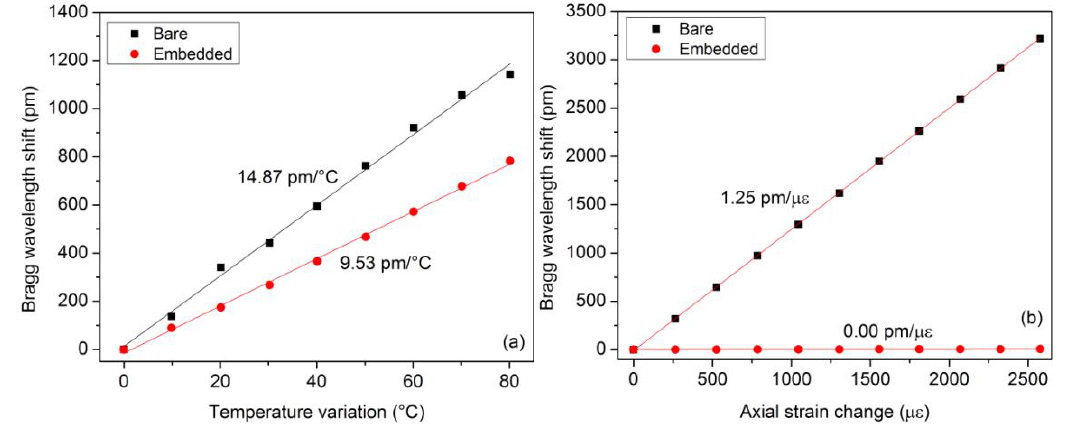
Figure 3. Bragg wavelength shifts as a function of strain and temperature for both FBGs integrated into the composite material